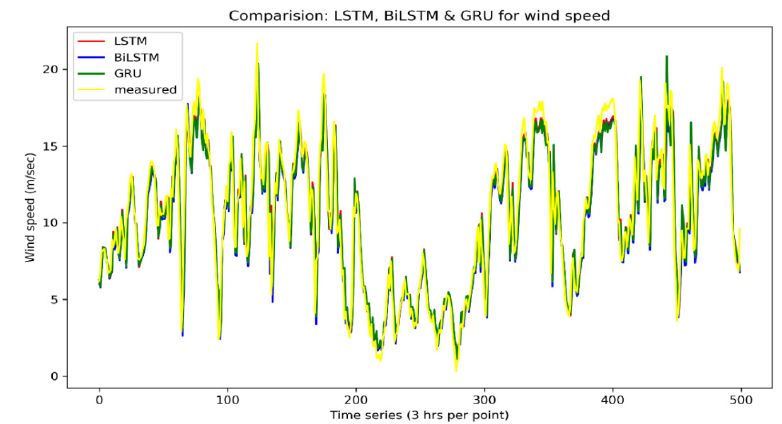
Figure 23. Performance comparison: wind speed.